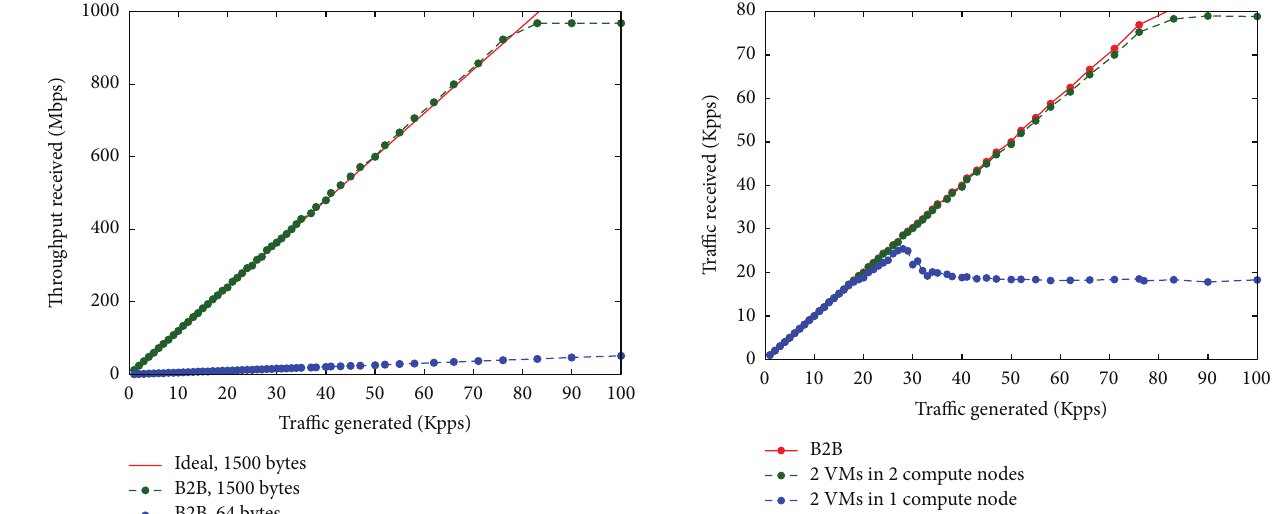
Figure 9: Throughput versus generated packet rate in the B2B setup for 64 - and 1500 -byte packets. Comparison with ideal 1500 -byte packet throughput.